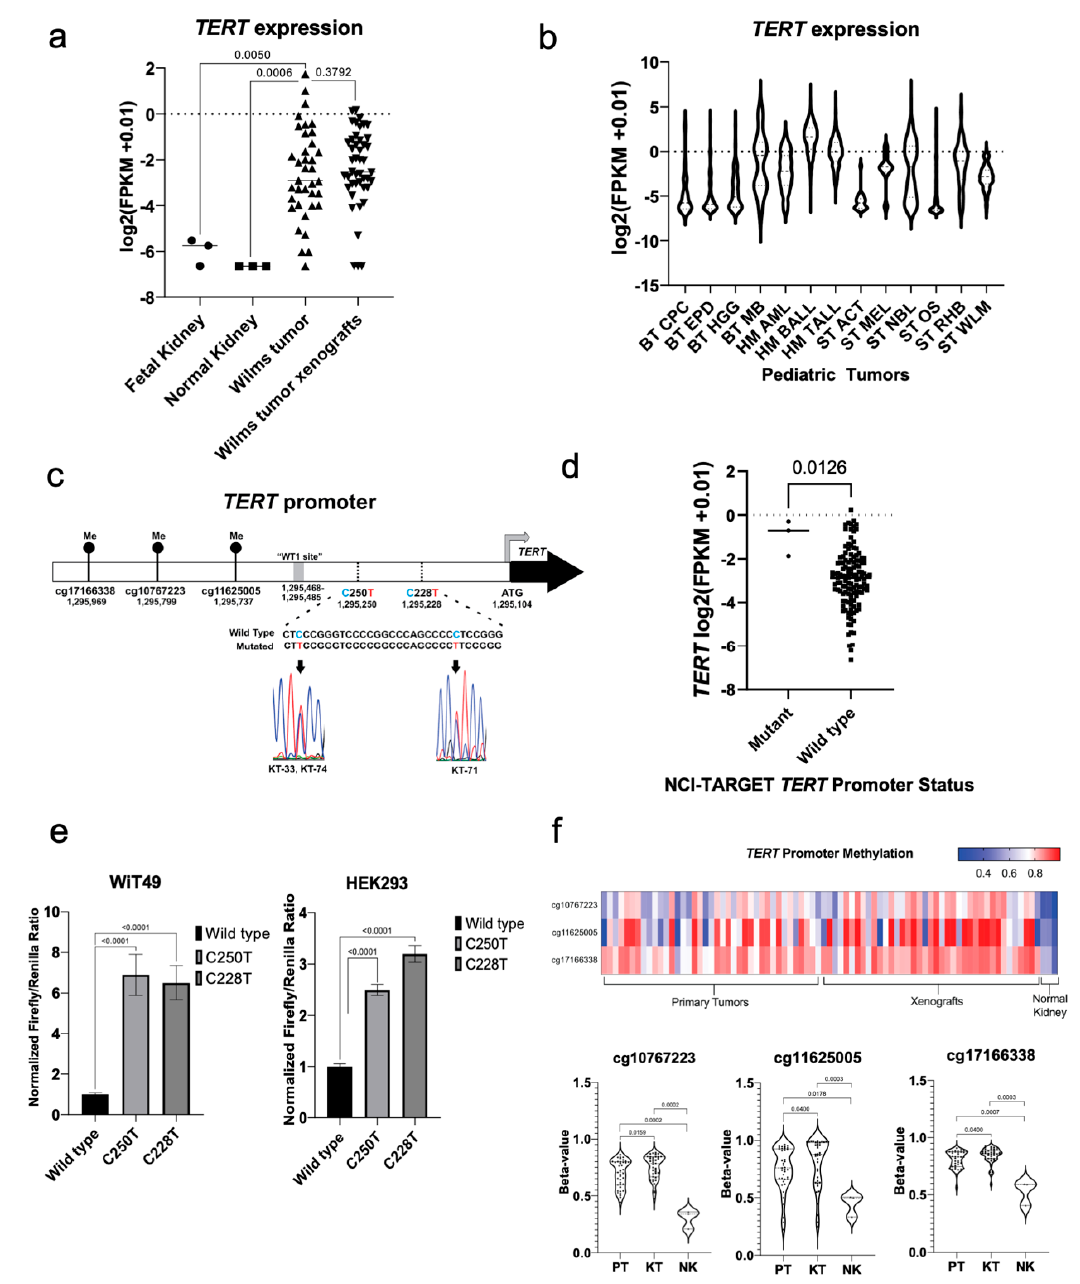
Figure 1. Mechanisms of TERT activation in Wilms tumor. ( a ) Wilms tumors have increased TERT expression compared to pooled fetal kidney mRNA (Mann-Whitney test p = 0.0050) and normal kidney ( p = 0.0006) by RNA-seq, but similar TERT expression when compared to associated patient-derived xenografts ( p = 0.3792). ( b ) RNA-seq TERT expression in Wilms tumor versus other pediatric solid tumors (BT—brain tumor, CPC—choroid plexus carcinoma, EPD—ependymoma, HGG—high grade glioma, MB—medulloblastoma, HM—hematologic malignancy, AML—acute myelogenous leukemia, BALL—B-cell acute lymphoblastic leukemia, TALL—T-cell acute lymphoblastic